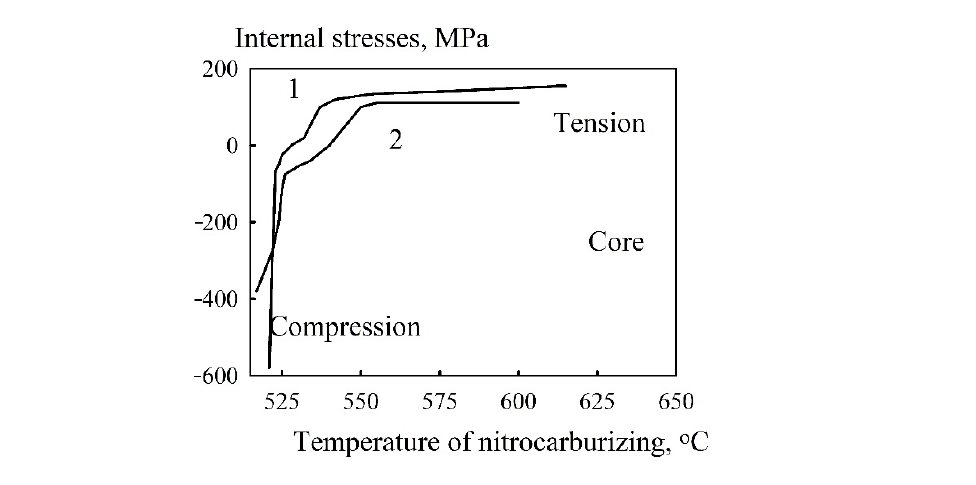
Figure 8. Distribution of internal stresses over the diffusion layer depth for nitrocarburized steels 09Cr15Ni8Al (1) and 60Si2Cr (2).